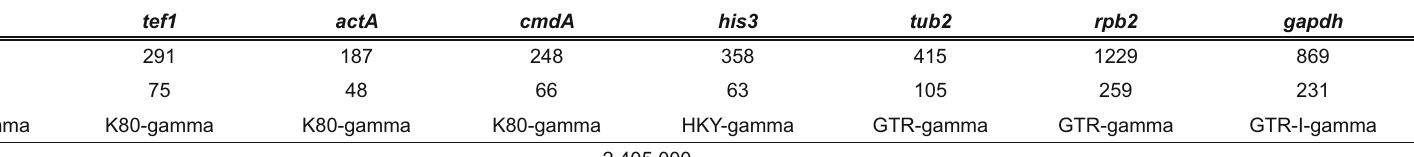
Table 3. =(cid:14)(cid:22)(cid:23)(cid:4)(cid:25)(cid:13)(cid:17)(cid:13)(cid:8)(cid:11)(cid:19)(cid:2)(cid:21)(cid:9)(cid:8)(cid:9)(cid:2)(cid:9)(cid:17)(cid:21)(cid:2)(cid:8)(cid:14)(cid:13)(cid:2)(cid:7)(cid:5)(cid:12)(cid:7)(cid:8)(cid:11)(cid:8)(cid:5)(cid:8)(cid:11)(cid:4)(cid:17)(cid:2)(cid:6)(cid:4)(cid:21)(cid:13)(cid:23)(cid:7)(cid:2)(cid:5)(cid:7)(cid:13)(cid:21)(cid:2)(cid:11)(cid:17)(cid:2)(cid:8)(cid:14)(cid:13)(cid:2)(cid:18)(cid:14)(cid:22)(cid:23)(cid:4)(cid:25)(cid:13)(cid:17)(cid:13)(cid:8)(cid:11)(cid:19)(cid:2)(cid:9)(cid:17)(cid:9)(cid:23)(cid:22)(cid:7)(cid:11)(cid:7)(cid:29)(cid:2)(cid:18)(cid:13)(cid:10)(cid:2)(cid:23)(cid:4)(cid:19)(cid:5)(cid:7)(cid:28)(cid:2)/(cid:12)(cid:12)(cid:10)(cid:13);(cid:11)(cid:9)(cid:8)(cid:11)(cid:4)(cid:17)(cid:7)(cid:2)(cid:4)(cid:26)(cid:2)(cid:23)(cid:4)(cid:19)(cid:11)(cid:2)(cid:26)(cid:4)(cid:23)(cid:23)(cid:4)(cid:15)(cid:2)<(cid:9)(cid:12)(cid:23)(cid:13)(cid:2)!(cid:28)